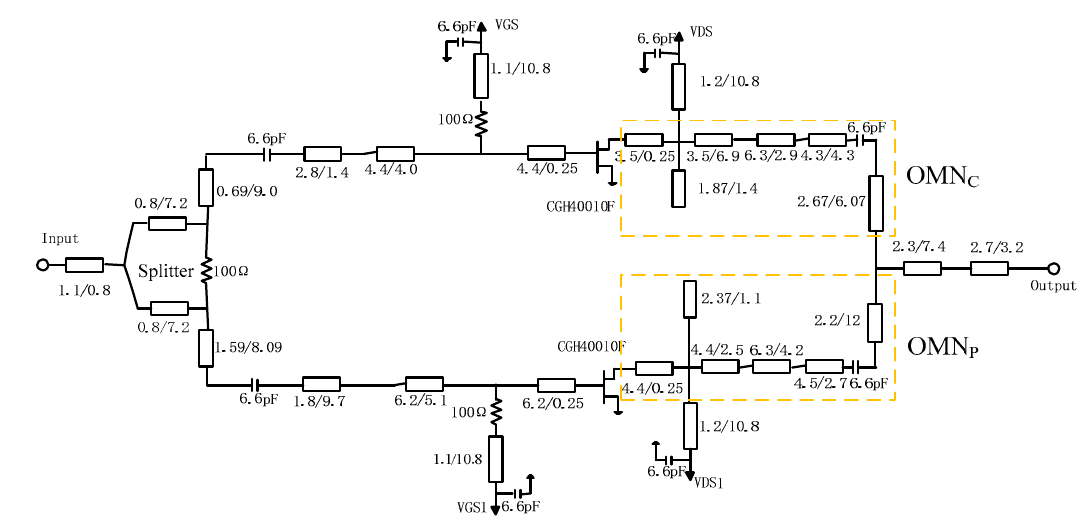
Figure 10. Completed circuit schematic and parameters value.